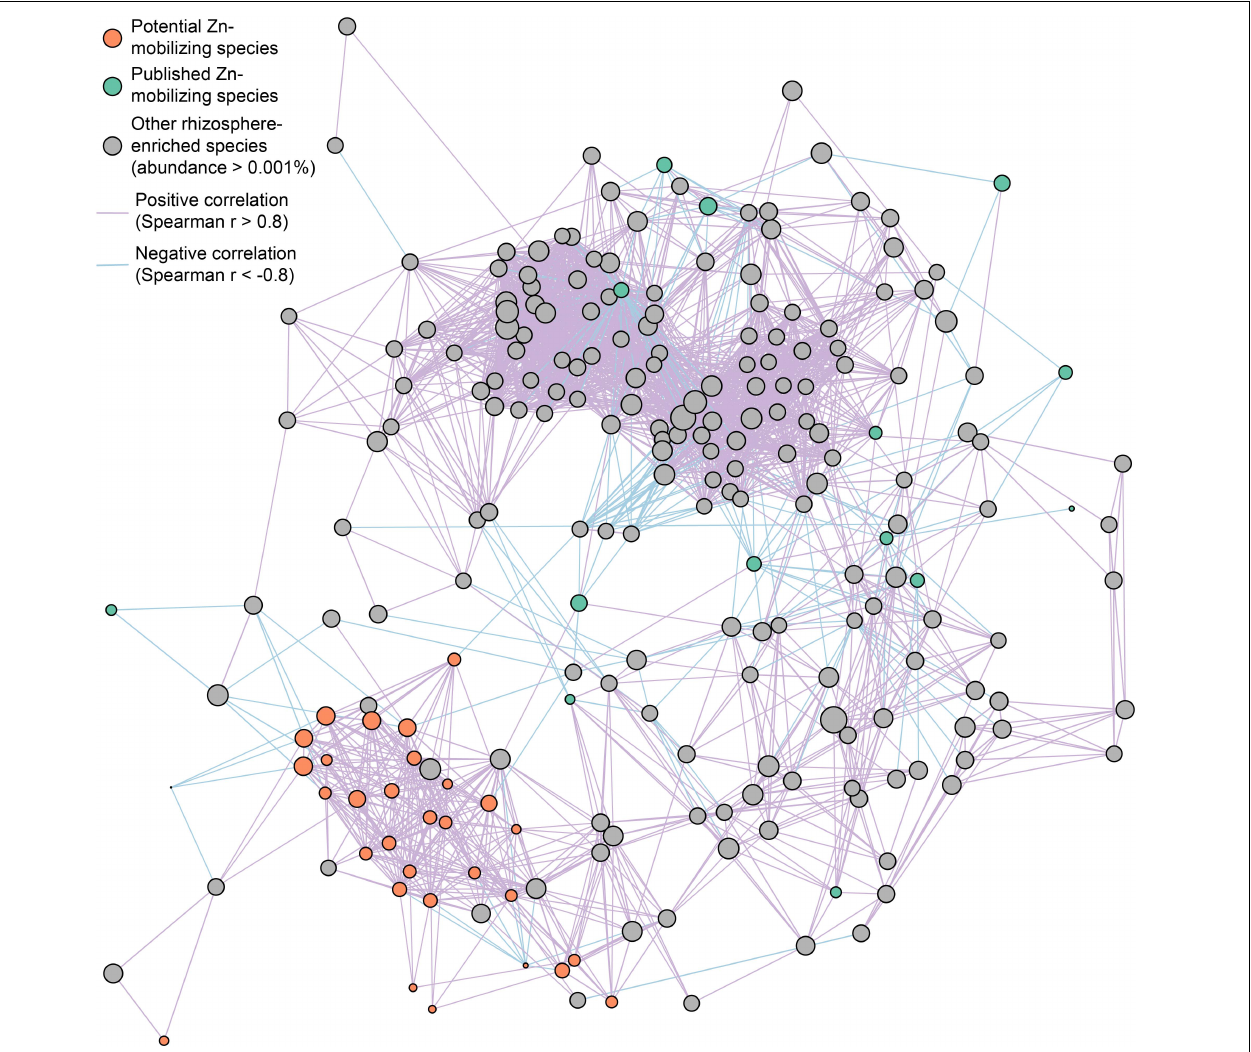
FIGURE 5 | Co-occurrence network of potential (orange circles) and published (green circles) soil Zn-mobilizing microbial species and other rhizosphere-enriched species (gray circles) with median relative abundances above 0.001% in high-Zn and low-Zn wheat cultivars. The size of each circle is proportional to the median relative abundance of the corresponding microbial species in wheat rhizosphere. The purple and blue lines linking circles refer to highly positive ( r > 0.8) and negative ( r < –0.8) Spearman’s correlations, respectively, between the relative abundances of the corresponding